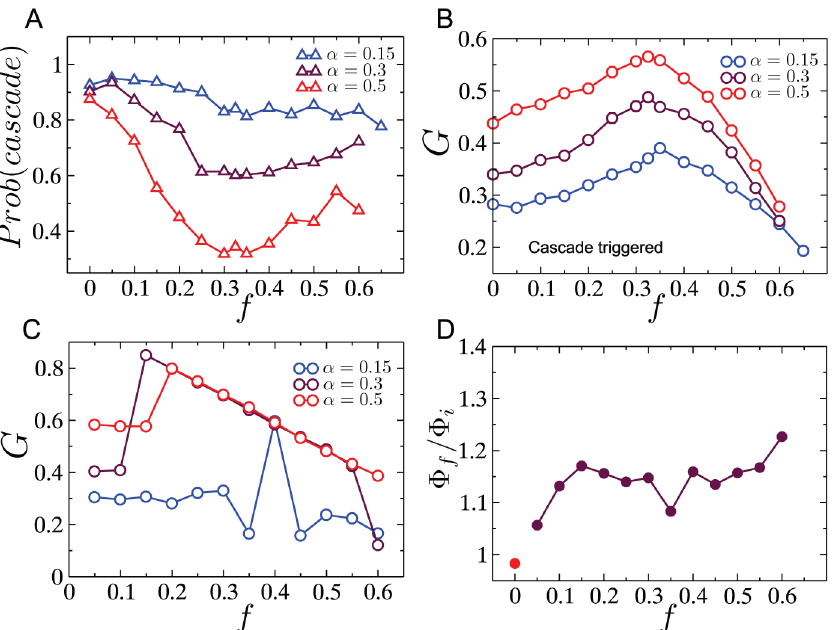
Figure 9. Preemptive node removal in RGGs. (A) Probability that a cascade occurs after removal of the node with highest load, despite a fraction f of nodes being preemptively removed immediately after the initial trigger. (B) Fractional size of the largest surviving network component G as a function of preemptively removed fraction f , when there is a cascade. (C) Fractional size of the largest surviving network component G as a function of preemptively removed fraction f for a single network instance for different values of the tolerance parameter a . (D) The ratio of the throughput (defined in text) of the surviving giant component and the throughput of the original network as a function of the altruist node fraction. The red circle corresponds to the case when there no nodes are preemptively removed. Network parameters are: N ~ 1500 , S k T ~ 6 : 0 : , and a ~ 0 : 15 for results shown in (A),(B) and (D).